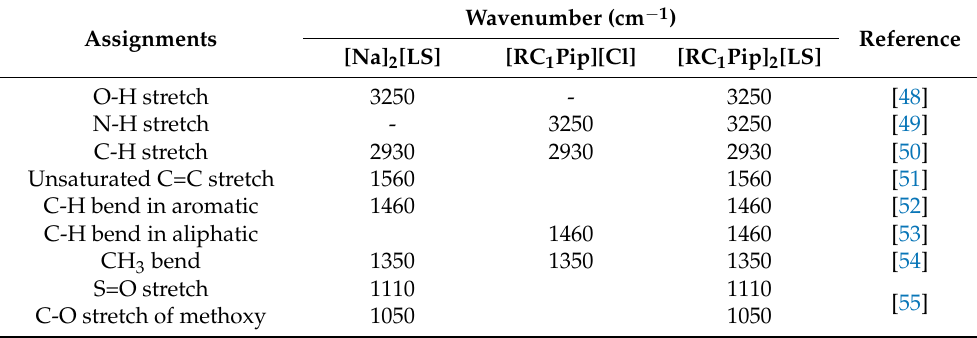
cm − 1 , (7) 1110 cm − 1 and (8) 1050 cm − 1 . Table 3. FTIR band